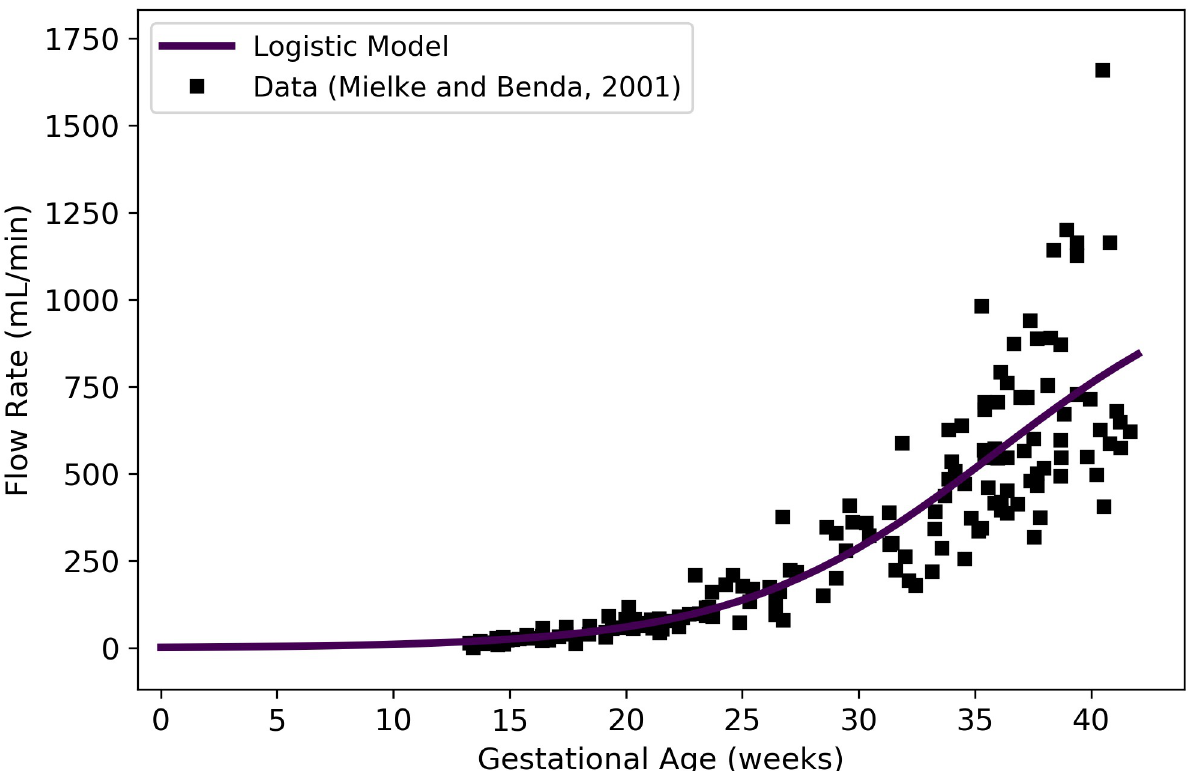
Fig 24. Fetal blood flow through the ductus arteriosus vs. gestational age. The logistic model (solid line) given by Eq 46 was selected as the most parsimonious model in our analysis, which utilized data of Mielke and Benda [39].